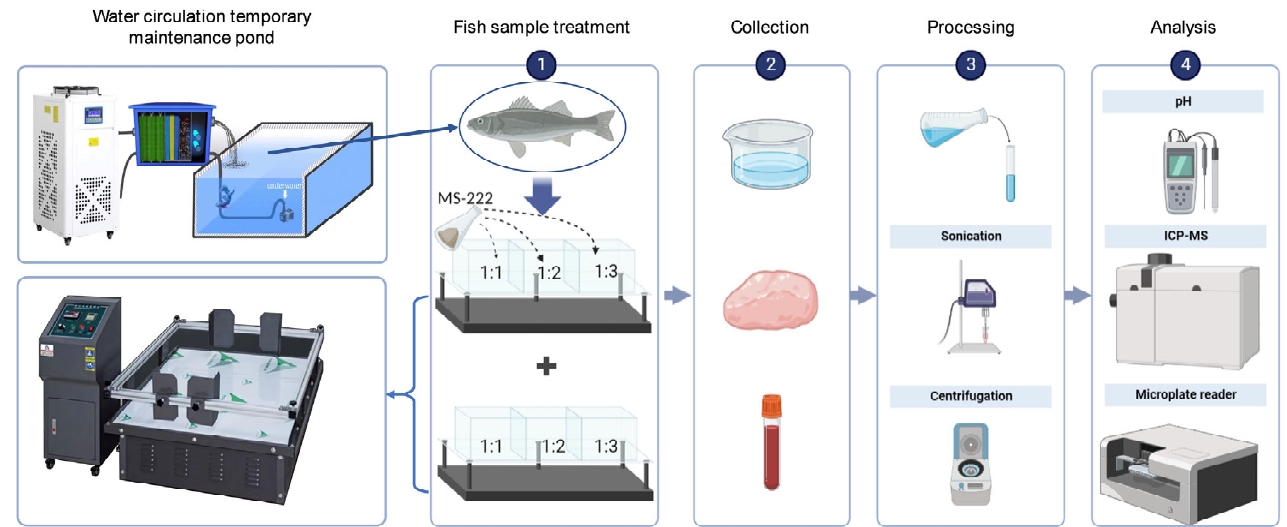
Figure 1. Schematic diagram of experimental design for simulating long-distance transportation of sea bass.